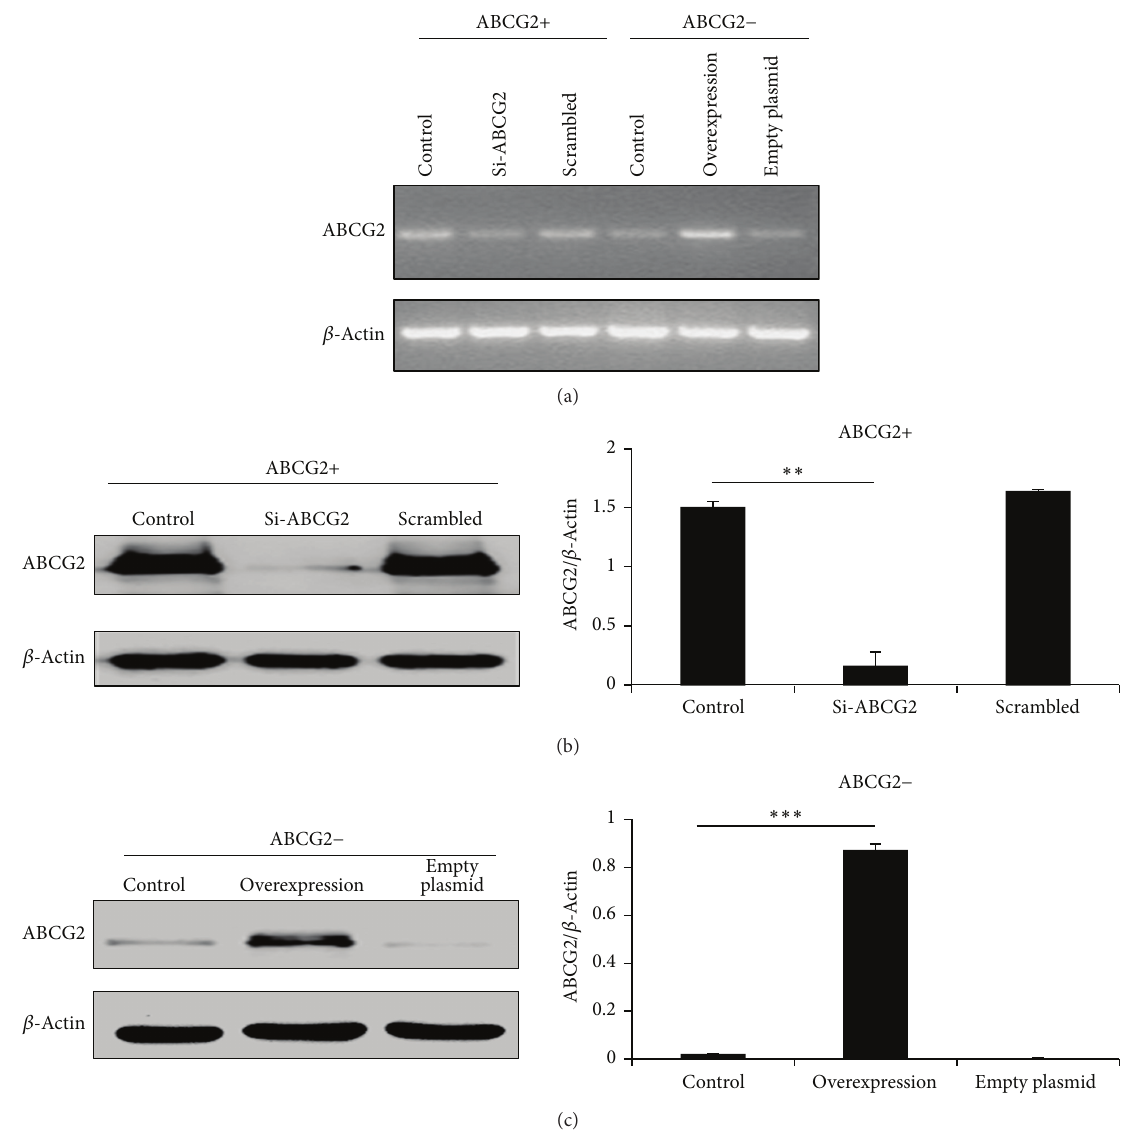
Figure 3: RNA interference and plasmid-mediated overexpression of ABCG2 in SMMC-7721 cells. (a) RT-PCR analysis of ABCG2 mRNA in SMCC-7721 cells after transfection with siRNA or plasmid for 48h. Normal SMMC-7721 cells were used as blank control. Scrambled siRNA was set as negative control. For overexpression, empty plasmid was transfected as negative control. (b), (c) Western blot analysis confirmed the efficiency of downregulation of ABCG2 by siRNA and upregulation by overexpression, respectively. 𝛽 -Actin served as loading control. The optical density was quantified and normalized to 𝛽 -Actin. ∗∗ 𝑃 < 0.01 , ∗∗∗ 𝑃 < 0.001